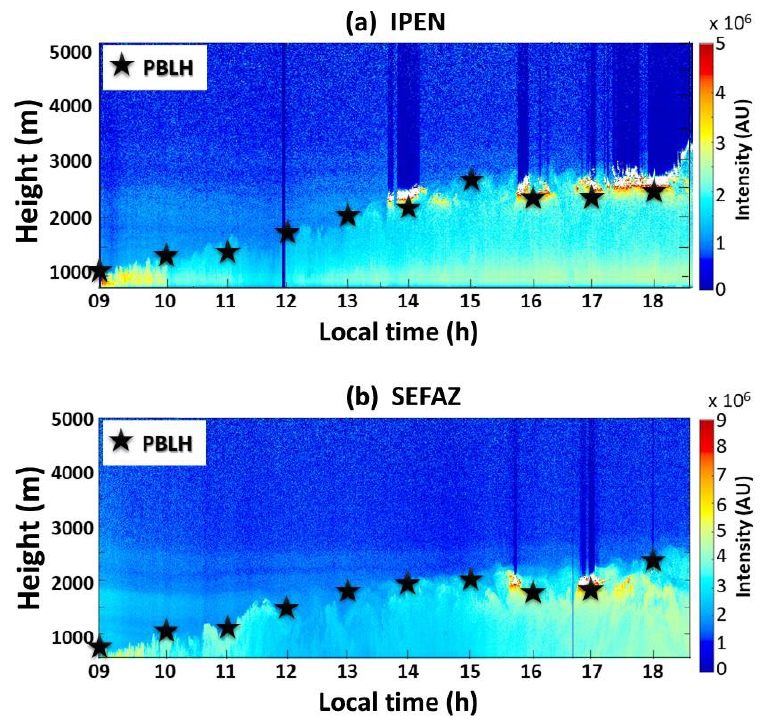
Figure 5. Diurnal evolution of ( a ) PBLH IPEN and ( b ) PBLH SEFAZ and corresponding RCS-Intensity curtain plot on 8 August 2019. Hourly values of PBLH are indicated by black stars.